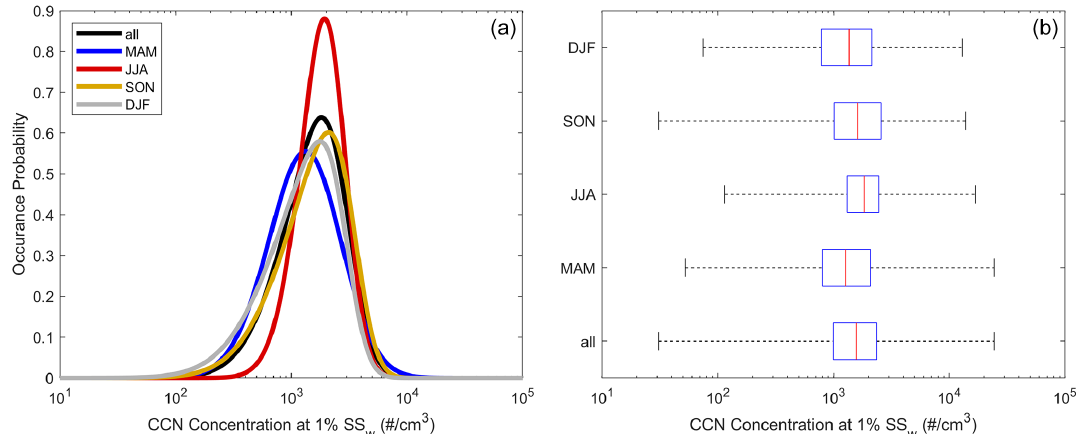
Figure 8. Distributions of the CCN concentrations at 1% SS w separated seasonally, using skewed log-normal fits (a) and box plots (b)